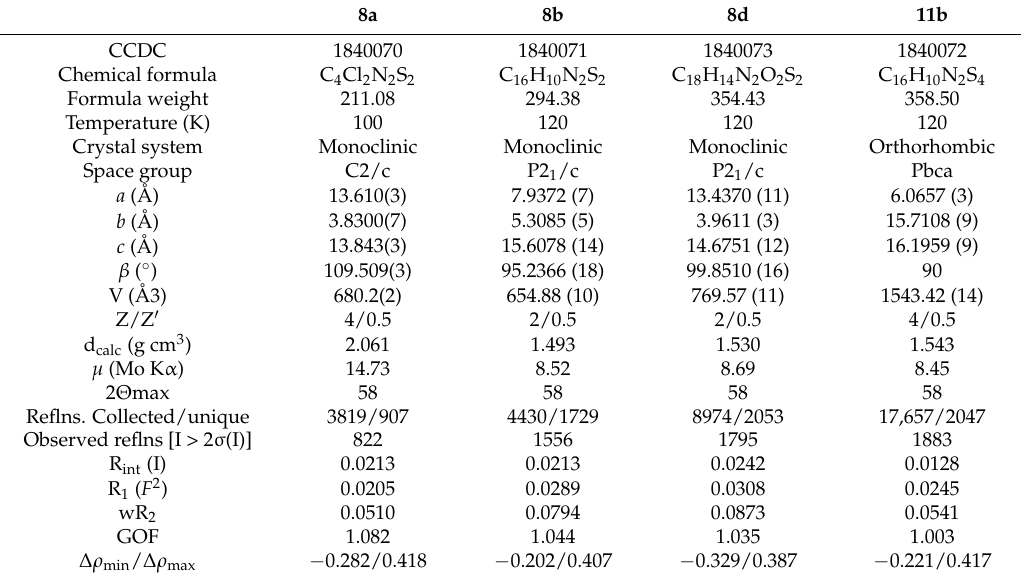
Table 3. Crystallographic data for 8a , 8b , 8d and 11b